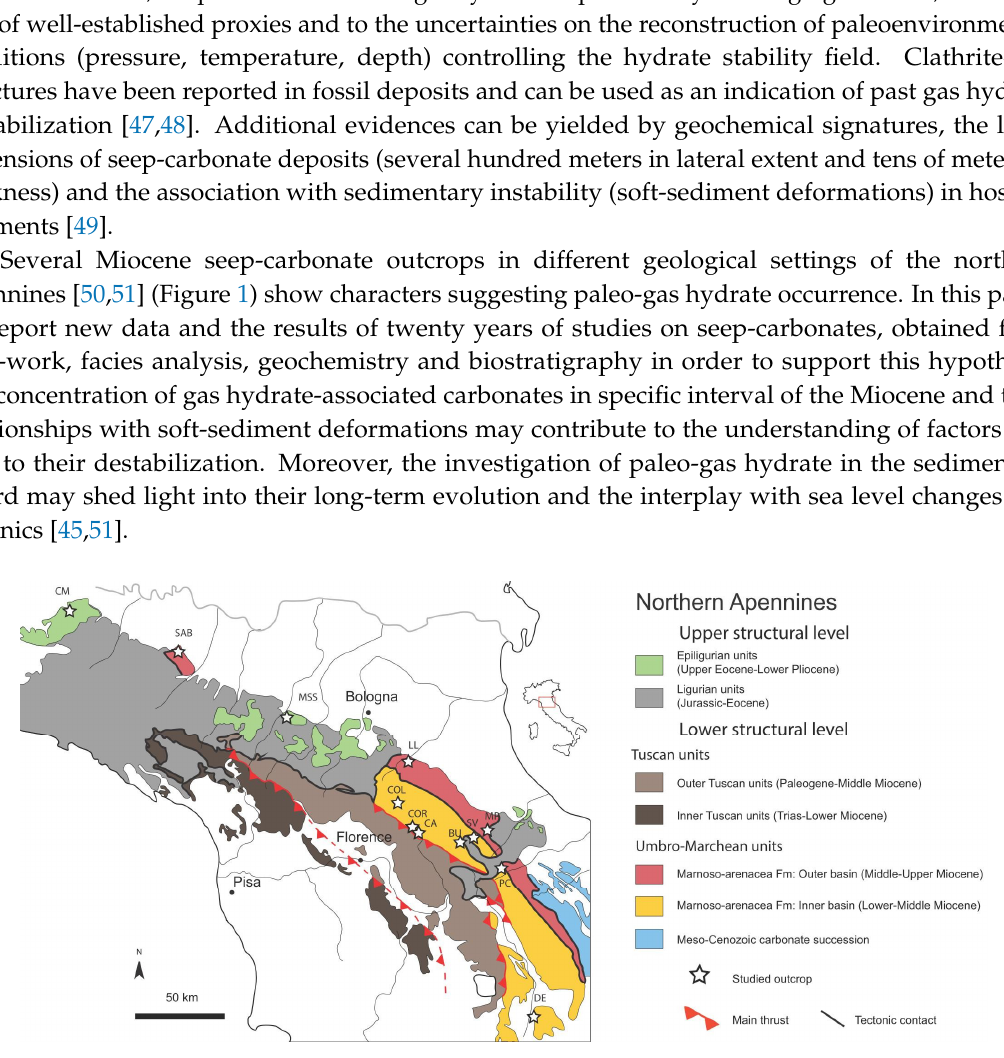
Figure 1. Simplified geological map of the northern Apennines (Italy) showing the main structural units and the location of the studied outcrops: CM = Cappella Moma [44 ◦ 56 (cid:48) 19.7” N; 9 ◦ 04 (cid:48) 54.7” E], SAB = Salsomaggiore [44 ◦ 44 (cid:48) 22.8” N; 10 ◦ 04 (cid:48) 56.5” E], MSS = Montardone, Sasso Streghe [44 ◦ 28 (cid:48) 40.3” N; 10 ◦ 47 (cid:48) 40.7” E], LL = Lame, Rontana [44 ◦ 14 (cid:48) 08.3” N; 11 ◦ 42 (cid:48) 57.0” E], COL = Colline, Mondera [44 ◦ 06 (cid:48) 41.6” N; 11 ◦ 34 (cid:48) 22.8” E], COR = Corella, Casellino [43 ◦ 56 (cid:48) 59” N, 1134 (cid:48) 59.8” E], CA = Castagno d’Andrea [43 ◦ 53 (cid:48) 15.1” N; 11 ◦ 40 (cid:48) 32.6” E], MP = Montepetra [43 ◦ 55 (cid:48) 50.3” N; 12 ◦ 11 (cid:48) 38.2” E], SV = San Vernicio [43 ◦ 54 (cid:48) 58.4” N; 11 ◦ 57 (cid:48) 58.3” E], BU = Case Buscarelle [43 ◦ 54 (cid:48) 50.6” N; 11 ◦ 55 (cid:48) 30.4” E], PC = Poggio Campane [44 ◦ 43 (cid:48) 52.0” N; 12 ◦ 14 (cid:48) 18.9” E], DE = Deruta [42 ◦ 58 (cid:48) 33.3” N; 12 ◦ 26 (cid:48) 21.1”